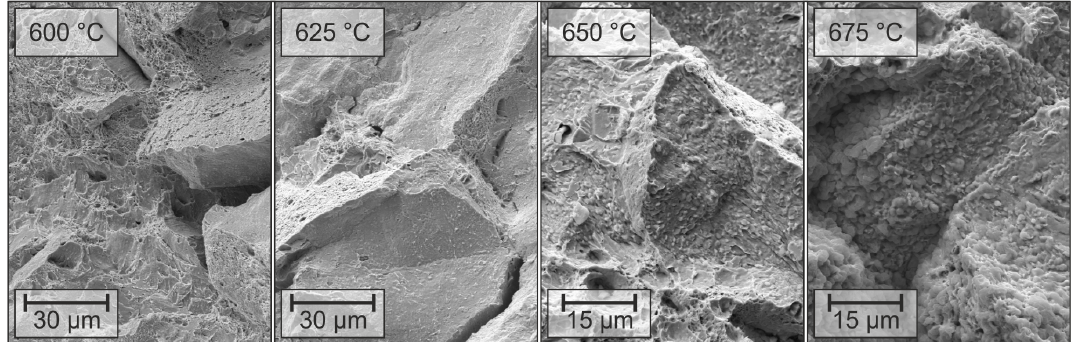
Figure 6. Scanning electron microscopy (SEM) micrographs of the fracture surfaces of Charpy-V-notch impact samples, annealed at different temperatures. Exemplary alloy L2 is shown in this figure.